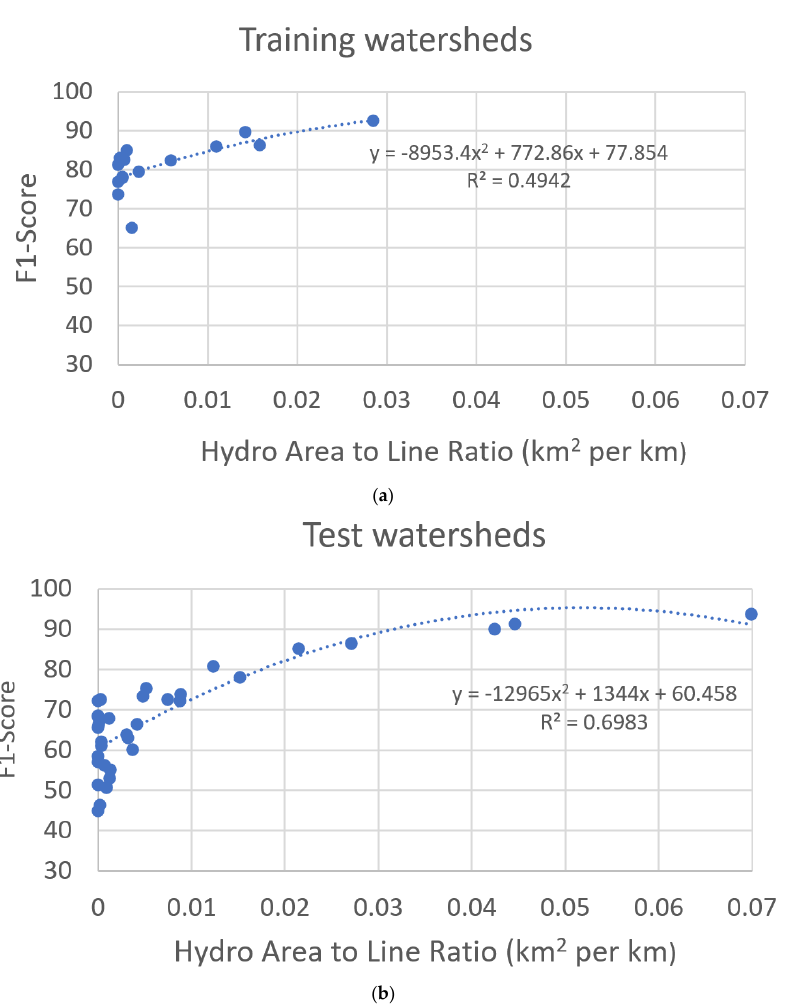
Figure 11. Comparison of F1-scores from model 14 with the ratio of the total area of waterbody features to the total length of flowline features for ( a ) training watersheds and ( b ) test watersheds. Waterbody area and flowline length are determined from the reference hydrography. Polynomial relations for training and test watersheds have R 2 values of 0.49 and 0.70, respectively.